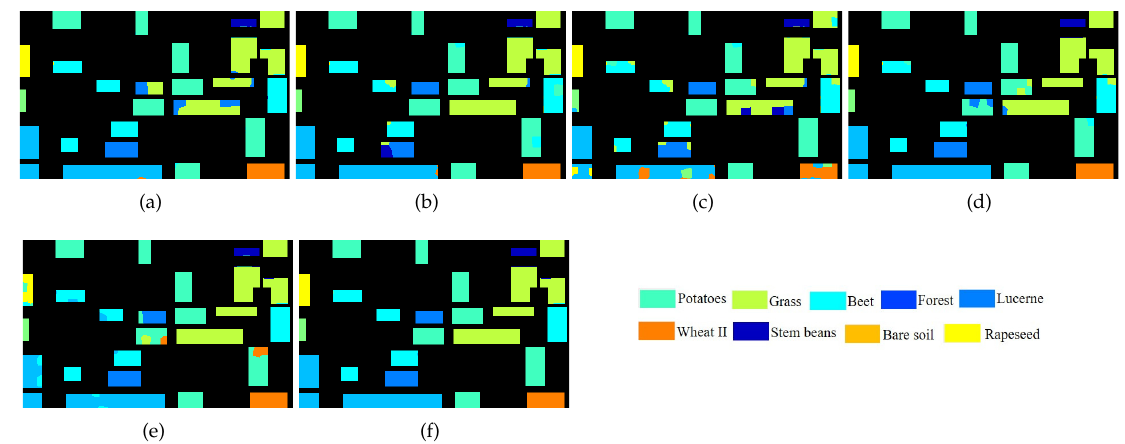
Figure 8. Visual classification results on the subset of the Flevoland data set. ( a ) the Wishart classifier,